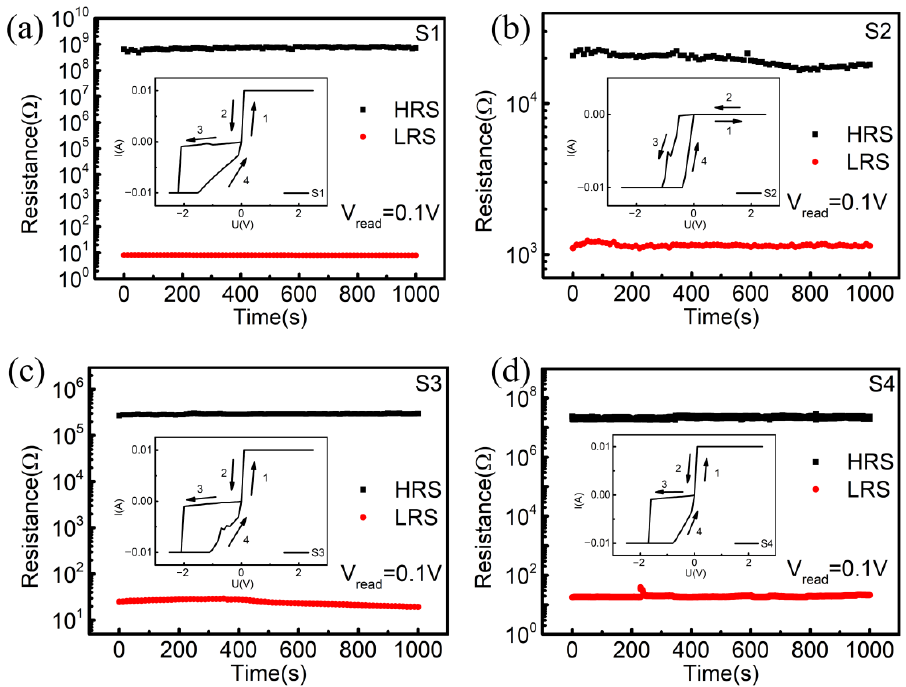
Figure 2. The resistive switching characteristics of ( a ) S1, ( b ) S2, ( c ) S3 and ( d ) S4. The insets show the I–V curves of each sample.